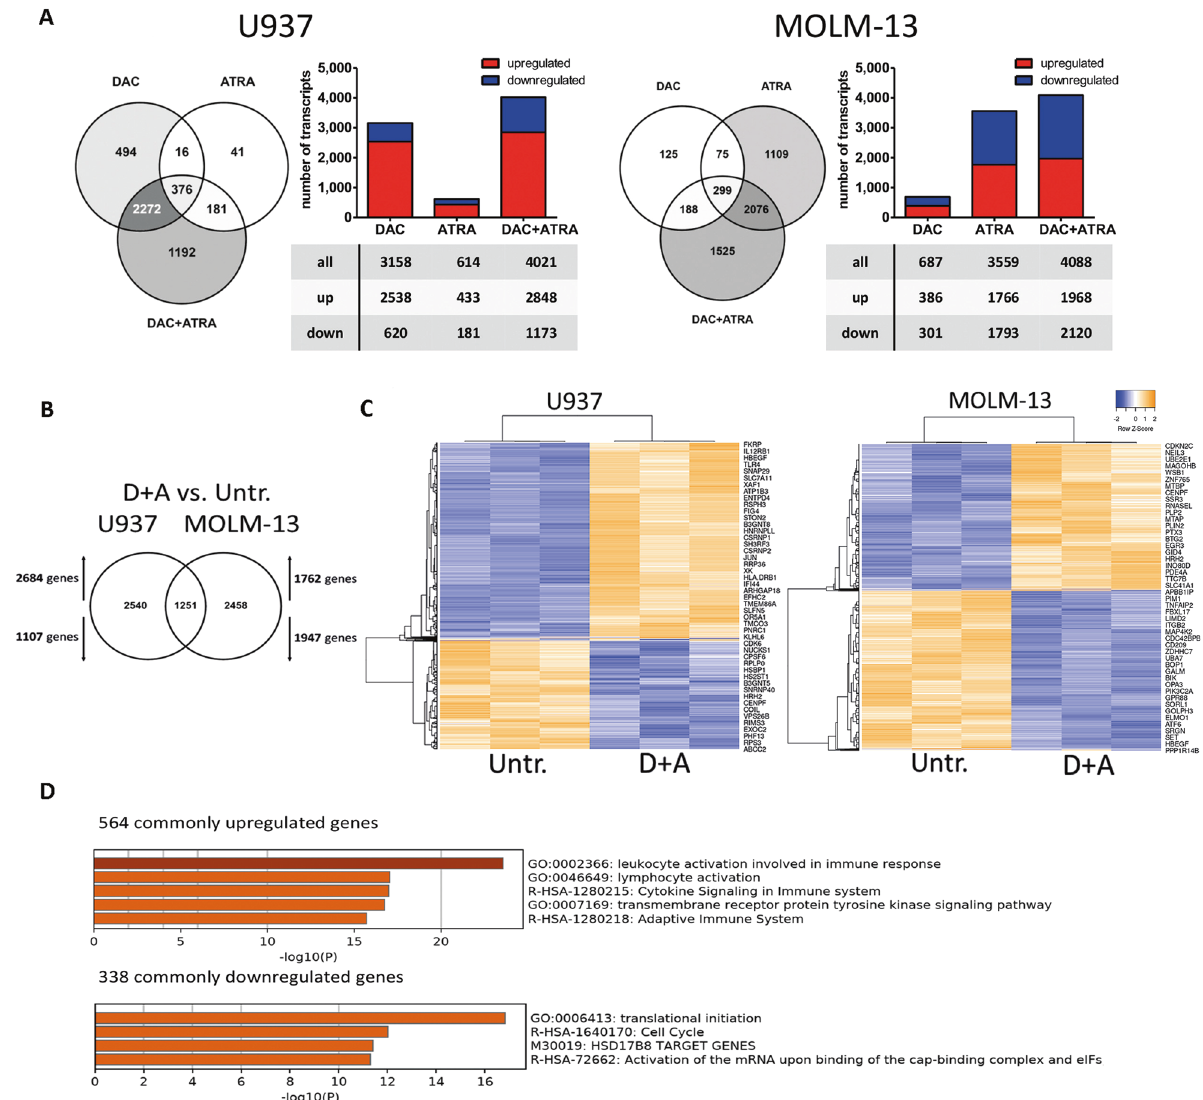
Fig. 2 Decitabine and all- trans retinoic acid cooperate in inducing transcriptome changes in AML cells. A Global expression changes in U937 and MOLM-13 were measured by RNA-seq (FDR < 0.01). Cells were treated with DAC, ATRA or both in combination, and harvested 72 h after the fi rst dose of Decitabine. Bar and Venn diagrams depict the numbers of altered transcripts in comparison to untreated; upregulated transcripts are shown in red, downregulated in blue. B Comparison of signi fi cantly regulated genes in U937 and MOLM-13 treated with DAC + ATRA vs. untreated (determined by RNA-seq). C Heatmaps (unsupervised clustering) of the commonly regulated genes in U937 or MOLM-13, comparing untreated (untr.) to DAC + ATRA-treated cells. D GO analysis for the commonly up- or downregulated genes in U937 and MOLM-13 by DAC +